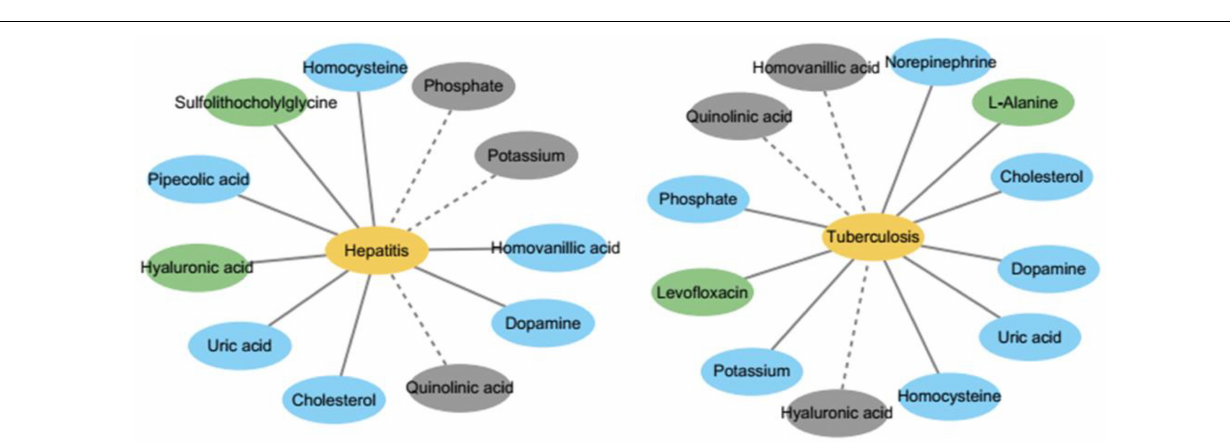
FIGURE 7 | The network of metabolites and diseases. It shows that the top 10 predicted and known metabolites used in this study for two diseases, respectively. The yellow nodes represent diseases and green nodes represent known metabolites which are respective related to two diseases. The blue nodes represent predicted metabolites associated with two disease which are verified by literature, while the gray nodes represent unconfirmed metabolites in top 10 predicted